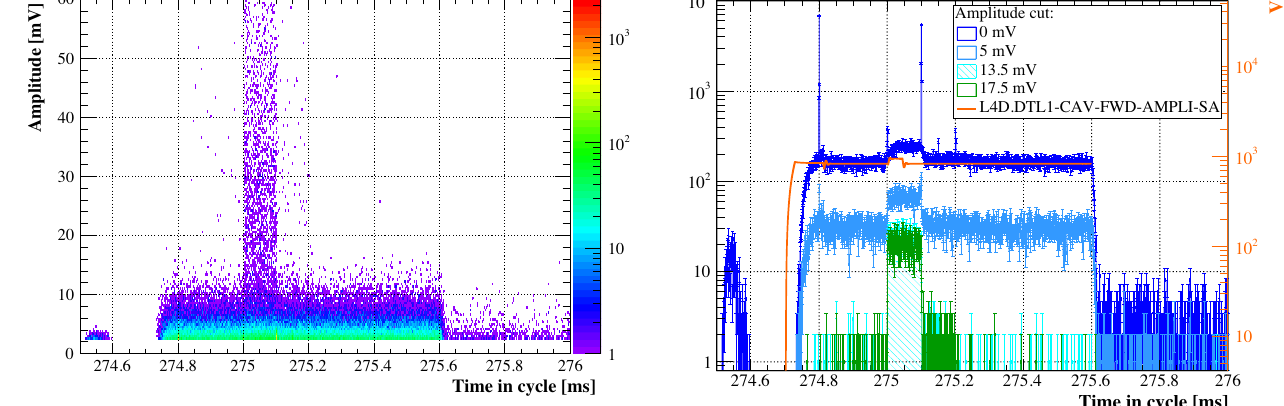
FIG. 10. Projections of the histogram from Fig. 9 on the time axis for different threshold cuts on the minimum event amplitude. Orange scale on the right side of the plot refers to the scale for the measurement marked with orange line. This line represents the cavity forward rf amplitude of the DTL tank 1 as measured by the LINAC4 operations